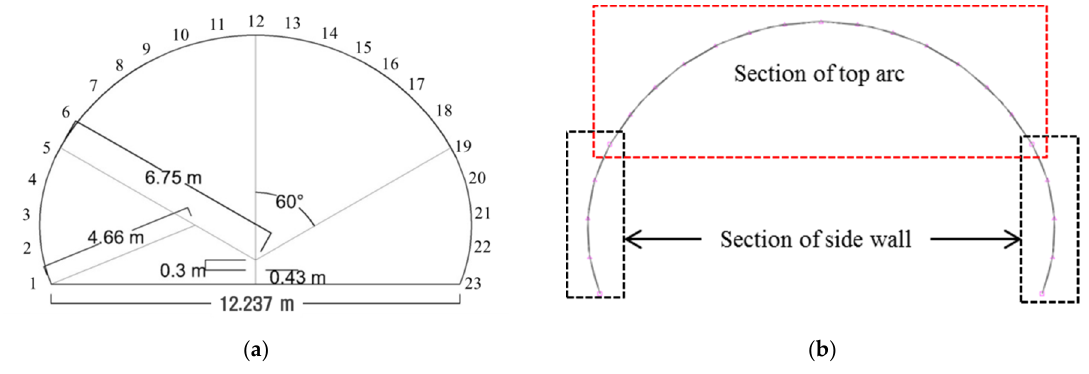
Figure 13. Modeling of analytical tunnel lining. ( a ) Schematic diagram and ( b ) mesh.